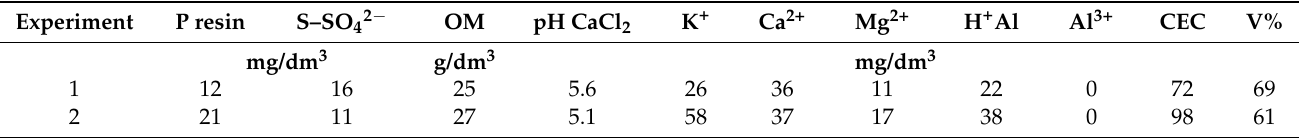
Table 1. Soil chemical attributes of the experimental area at the depth of 0–20 cm, Jaboticabal–SP.